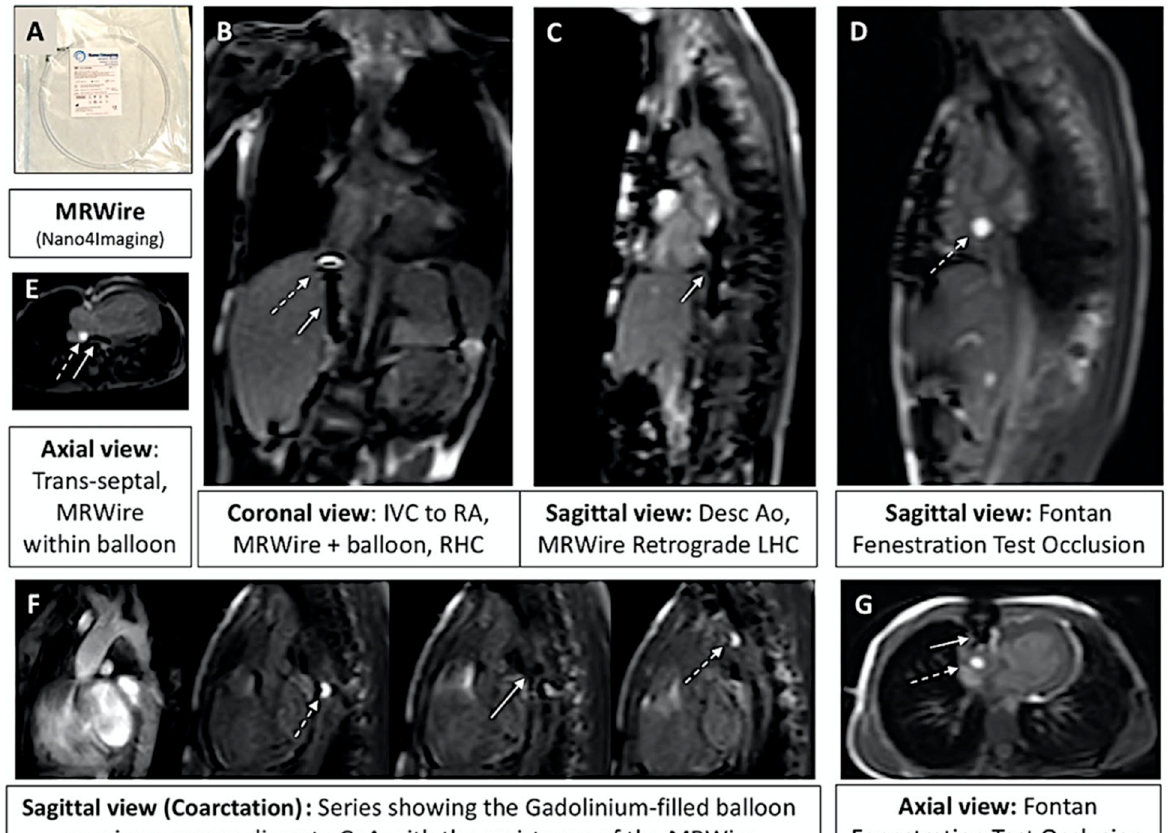
Figure 24. Overview of several examples using iCMR. ( A ) Packaging for the MR-conditional guidewire used to navigate catheters. ( B ) Prograde right heart catheterization (RHC) with the gadolinium-filled balloon-tip catheter (dashed arrow) and the MR conditional guidewire (solid arrow) positioned within IVC just prior to the RA entrance. ( C ) Retrograde LHC with the MR-conditional guidewire within the descending aorta at the level of the diaphragm. ( D ) Sagittal view of a Fontan fenestration test occlusion (FFTO) to test eligibility for device closure. ( E ) Prograde evaluation of pulmonary veins across the atrial septal defect. ( F ) Retrograde LHC in a patient with CoA to define gradient prior to transfer to the fluoroscopy suite for stent placement. ( G ) Additional view from an axial view demonstrating FFTO to test eligibility for device closure. Revised from ref [16].